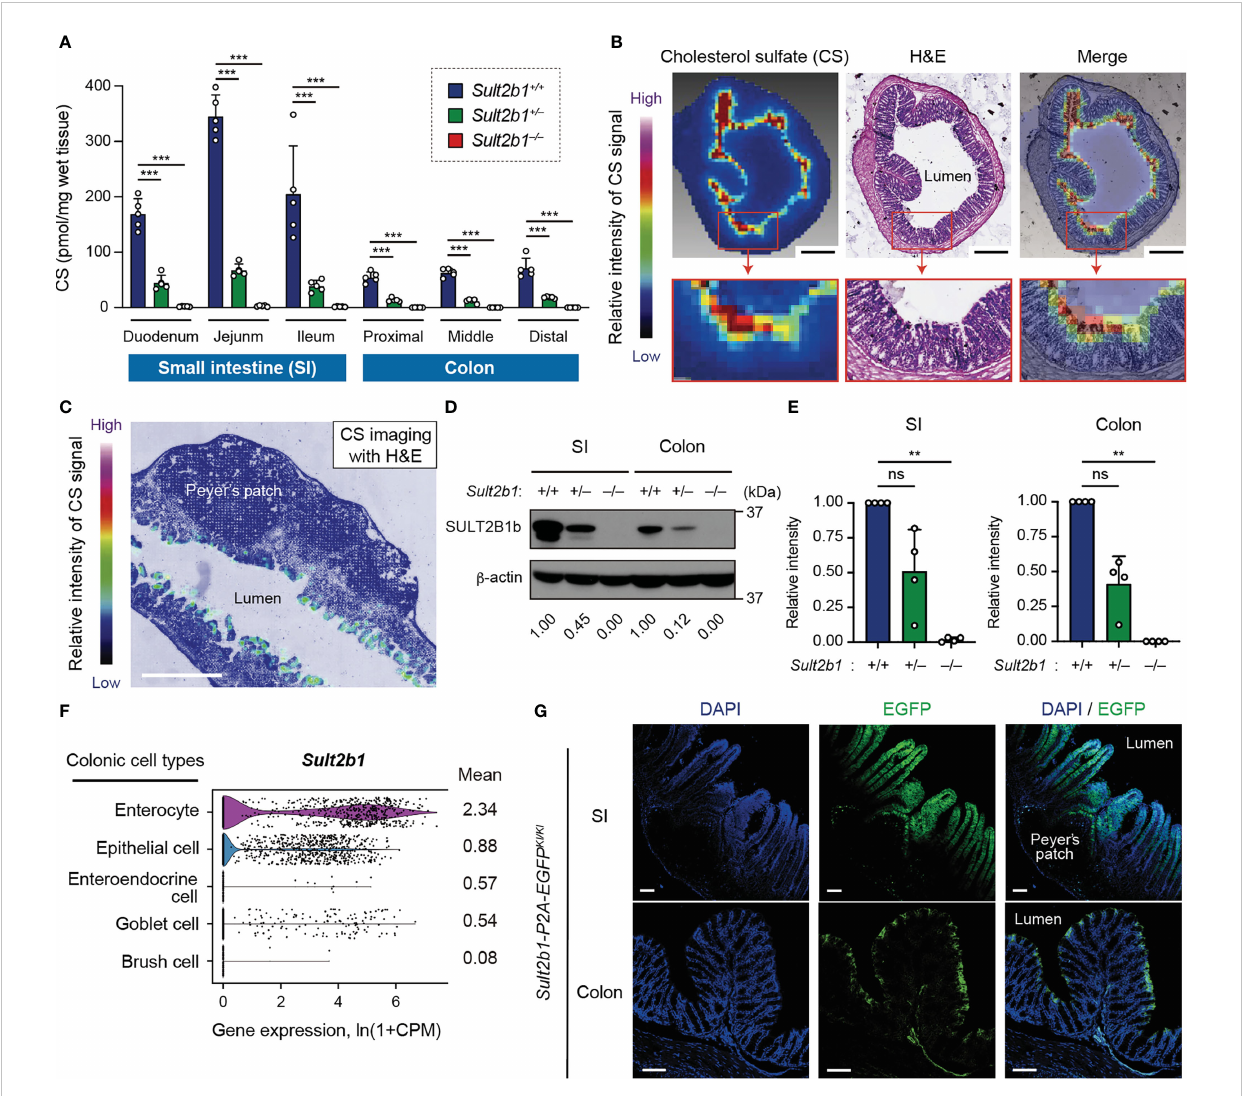
FIGURE 1 Endogenous CS is produced at the mucosal-luminal interface. (A) The amount of CS in the SI and colon of Sult2b1 +/+ , Sult2b1 +/ − , and Sult2b1 − / − mice were quanti fi ed using liquid chromatography-tandem mass spectrometry (LC-MS/MS; n = 5 mice per group; one-way ANOVA with Dunnett ’ s multiple comparison test). (B, C) Localization of CS in sections of the colon and SI in Sult2b1 +/+ mice visualized using hematoxylin and eosin (H&E) staining and MS imaging. Color bar indicates the relative intensities of the CS signal [mass/charge ratio ( m/z ) 465]. Scale bar, 500 m m. (D, E) Representative immunoblots showing SULT2B1b in the SI and colon. The numbers below the blot indicate the abundance of SULT2B1b relative to b - actin for each tissue and are normalized considering the abundance of SULT2B1b in Sult2b1 +/+ mice as 1. Bar graphs showing the quanti fi cation data of four individual blots for each tissue (n = 4; one-way ANOVA with Dunnett ’ s multiple comparison test). (F) Violin plots showing mouse Sult2b1 gene expression in each colonic cell type, analyzed using the Tabula Muris single-cell RNA-seq data (3-month-old C57BL/6JN mice). Data for gene counts from cells sorted using fl ow cytometry were normalized to counts per million (CPM) and presented as l n (1+CPM). The numbers next to the plots indicate mean expression of Sult2b1 in each cell type. (G) Representative images showing the SI and colon of Sult2b1-P2A-EGFP mice counterstained with 4 ′ ,6-diamidino-2-phenylindole (DAPI). Scale bar, 100 m m. Data were obtained from two (A-C) , four (D, E) , and three (G) independent experiments, and graphs are shown as the mean ± standard deviation (SD). ** P < 0.01; *** P < 0.001; ns, not signi fi